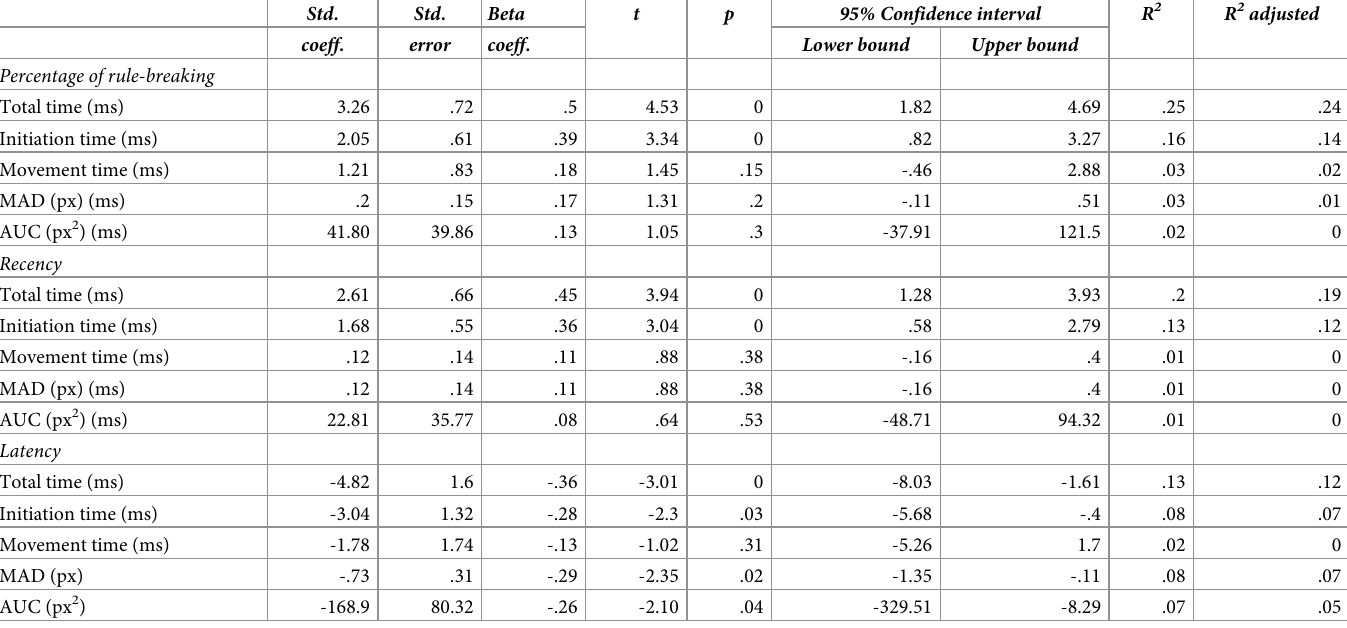
Table 2. The influence of frequency, recency, and latency of rule-breaking on reaction times and mouse trajectory parameters in the rule-part (rule-breakers, N = 63). Std . Std